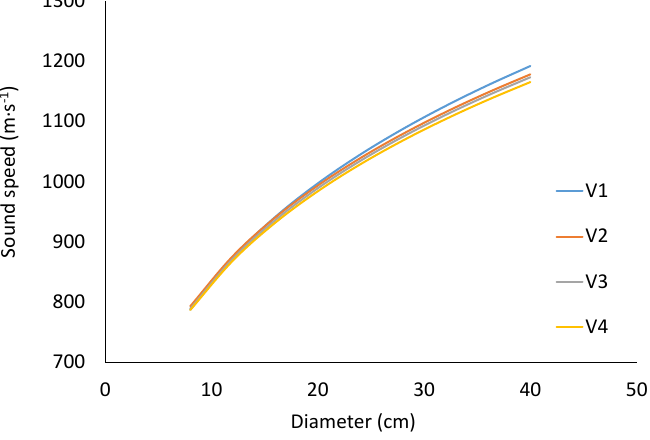
Figure 8. Average sound speed curves in relation with diameter and planting variant. Table 6. Result summary of two-way t significance tests between four variants of experimental plot for microdrilling.